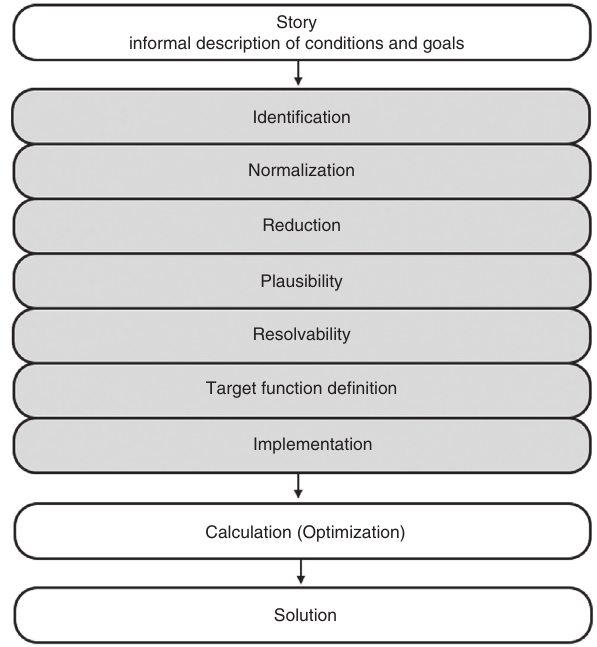
Figure 3. Transformation